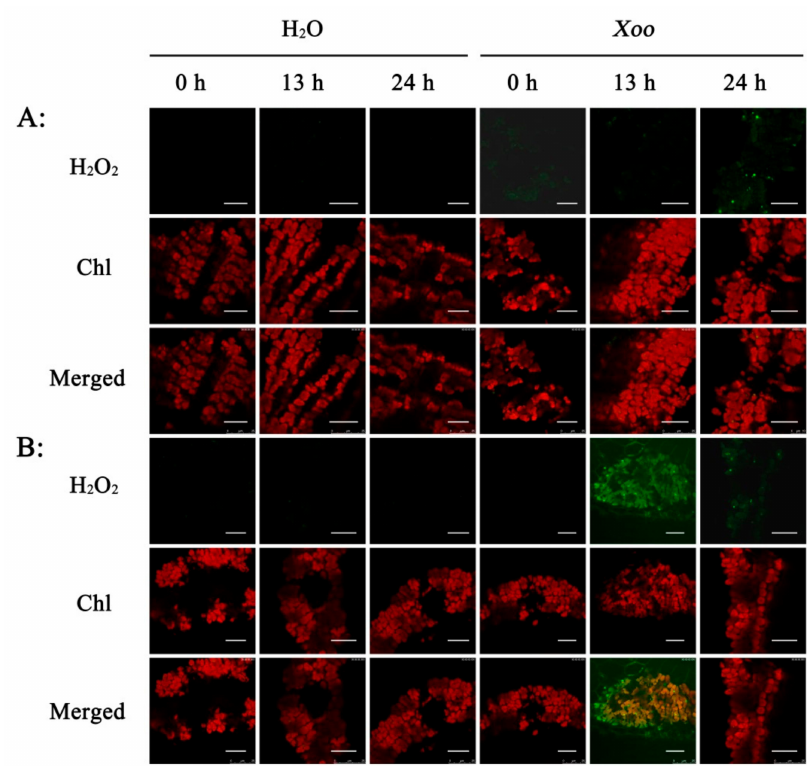
Figure 5. Subcellular localization of H 2 O 2 detected by H 2 DCFDA fluorescence imaging in Dalixiang and O. meyeriana 0 h, 13 h, and 24 h after Xoo inoculation. Rice leaf sections were incubated in 2, 7-Dichlorodi-hydrofluorescein diacetate (H 2 DCFDA) solution and then examined by confocal